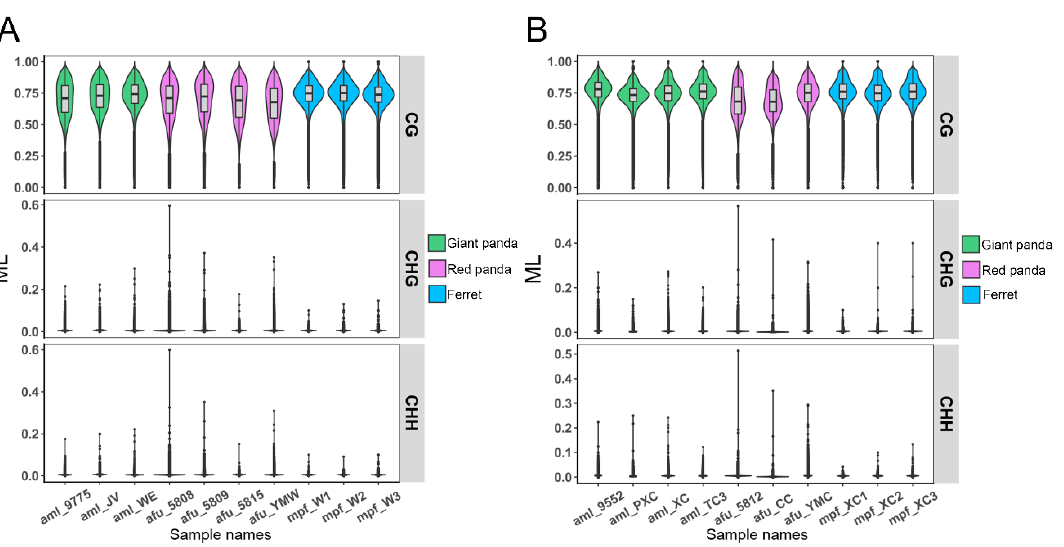
Figure 5. The distributions of methylation levels for the stomach ( A ) and small intestine ( B ) samples across the genomes of giant panda, red panda and ferret. The x-axis and y-axis represent different samples and methylation levels, respectively. Every 10 kb was considered a bin. The width of each violin represents the number of points below this methylation level.